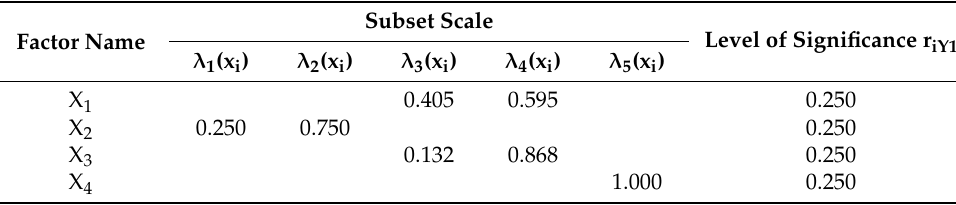
Table 6. Matrix of values for the factors of linguistic variable Y 1 for Saint